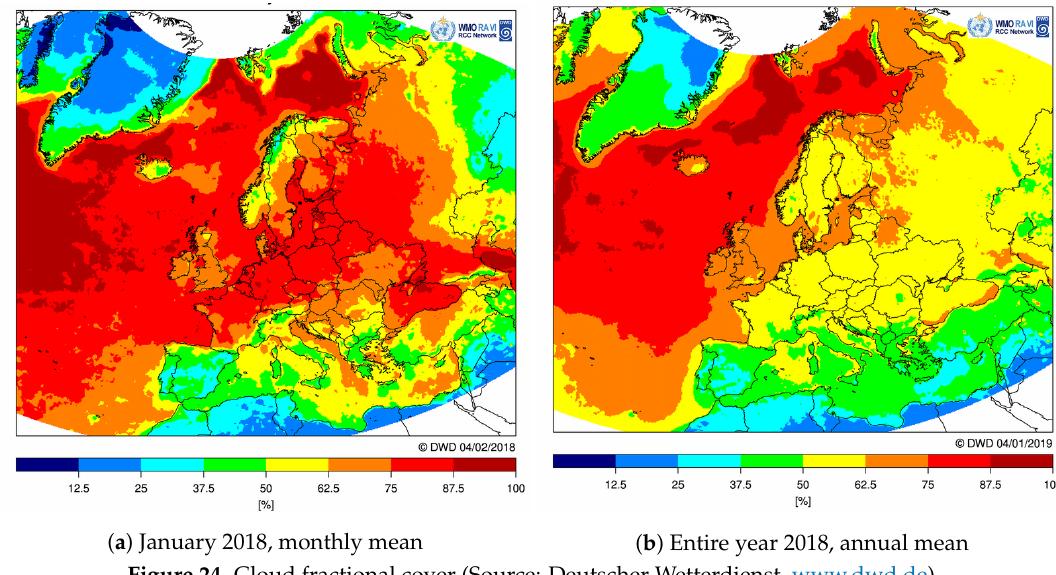
Figure 24. Cloud fractional cover (Source: Deutscher Wetterdienst,